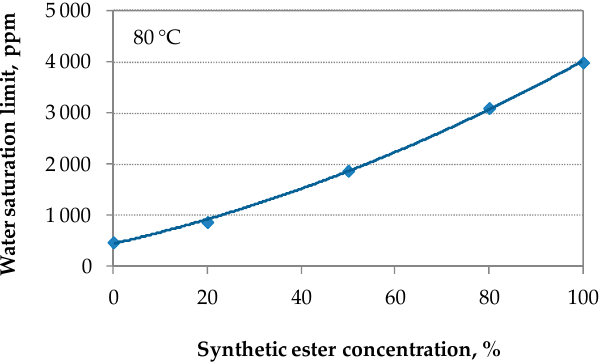
Figure 2. Water saturation limit for synthetic ester and mineral oil, and their mixtures at 80 °C; based on [18].